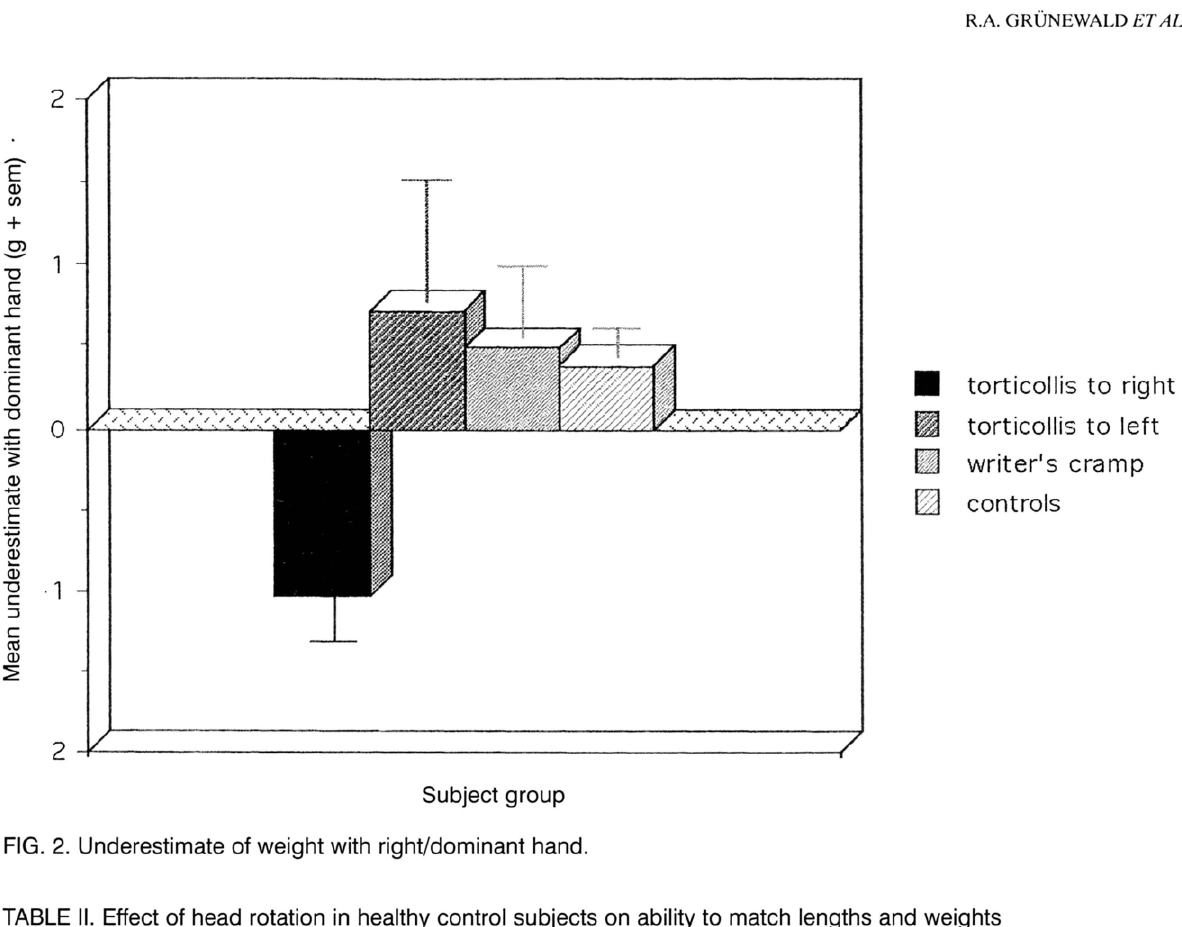
FIG. 2. Underestimate of weight with right/dominant hand. TABLE II. Effect of head rotation in healthy control subjects on ability to match lengths and weights Mean underestimate of weight with right hand (g ± standard error of mean) Mean underestimate of length with right hand (mm ± standard error of mean) ns = not significant: underestimates do not differ with head position by